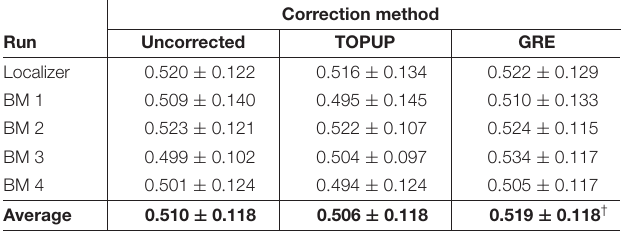
TABLE 5 | Average Dice coefficient values (across subjects) quantifying the spatial overlap between the RSN templates from Smith et al. (2009) and the selected group independent components, for each run (localizer and four biological motion runs), and also averaged across